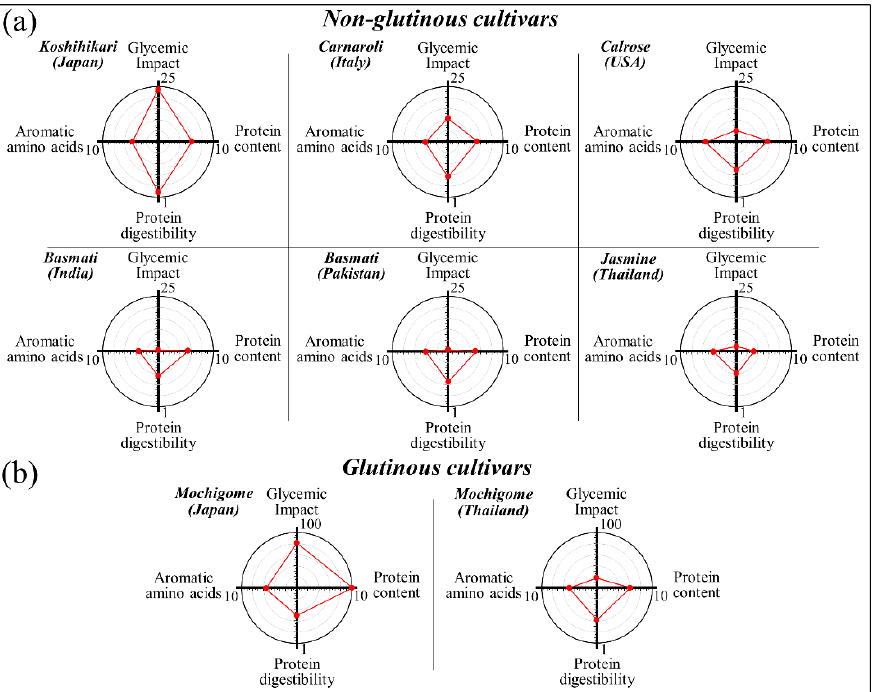
Figure 10. Polar diagrams comparing nutritional characteristics of non-glutinous ( a ) and glutinous ( b ) rice cultivars (cf. labels in inset); rotating clockwise from top: 0 ≤ GI ≤ 100 (glycemic impact, corresponding to the glycemic index ( GI ) relative to pure glucose), cumulative aromatic amino acid fraction, W Ph + W Tr (wt.%) ( W Ph is the weight fraction of Phenylalanine and W Tr is the weight fraction of Tryptophan), protein fraction, W Pr (wt.%) as defined by Equation (6), and protein digestibility ratio 0 ≤ R d ≤ 1 ( R d is the random coil-to- α -helix Raman sub-band intensity ratio).